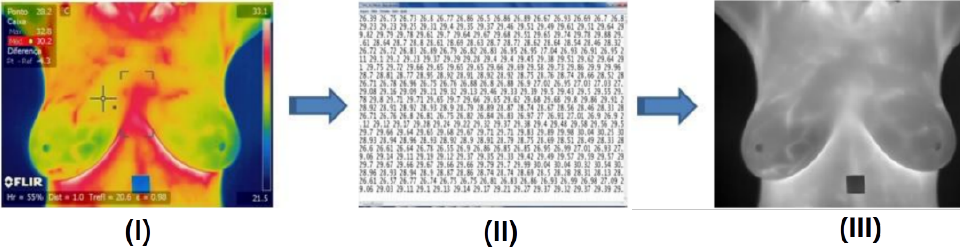
Figure 3. Extraction of temperature arrays from acquired frames and creation of an image from the temperature information. Copyright c (cid:13) 2019 IEEE, all rights